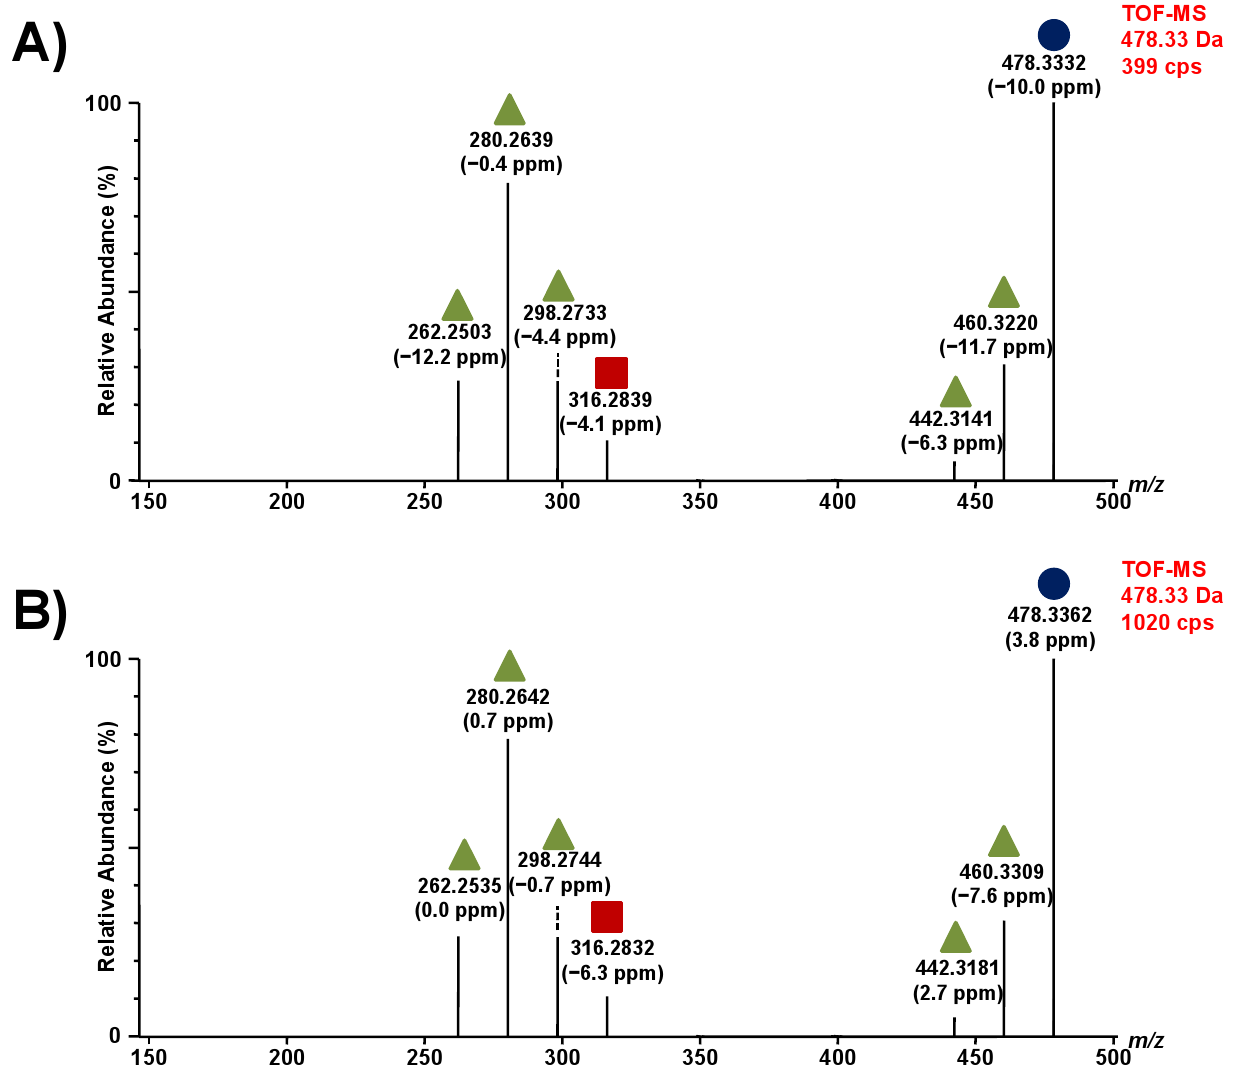
Figure 6. Fragmentation of lyso-Gb 1 analogs +16 Da. In ( A ), fragments from the metabolite with a retention time of 5.43 min; In ( B ), fragments obtained from the metabolite with a retention time of 5.65 min; in both ( A , B ), the molecular ion is indicated by a purple circle, a green triangle shows a loss of a water molecule, and a red square indicates a loss of a sugar unit. CPS: counts per second. Parts per million (ppm) refers to the difference between experimentally measured masses (accurate mass) and theoretical masses (exact mass).